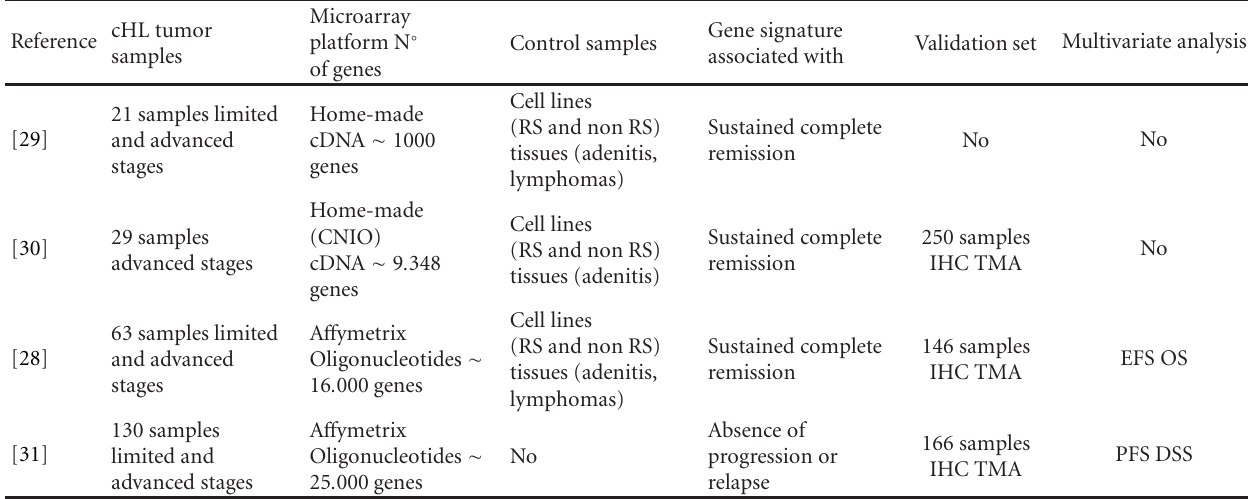
Table 1: Gene expression profiling studies of nonmicrodissected cHL and